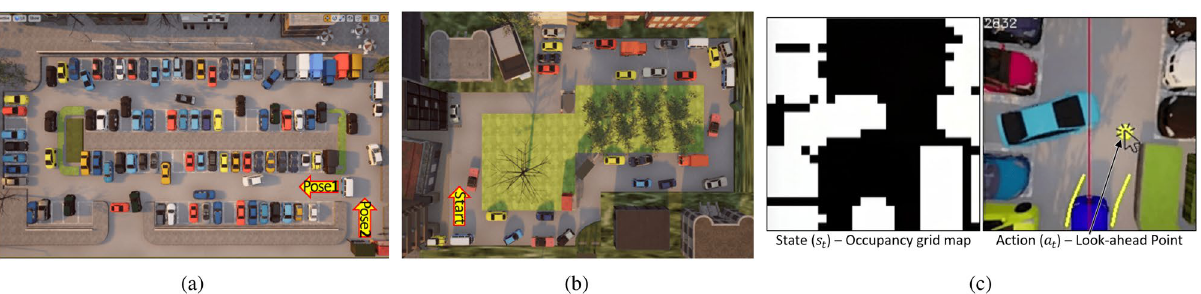
Figure 9. Semi-structured environments created using Unreal Engine4: ( a ) Trained environment (data collection and driving test) ( b ) Un trained environment (only driving test) ( c ) State and action in CARLA